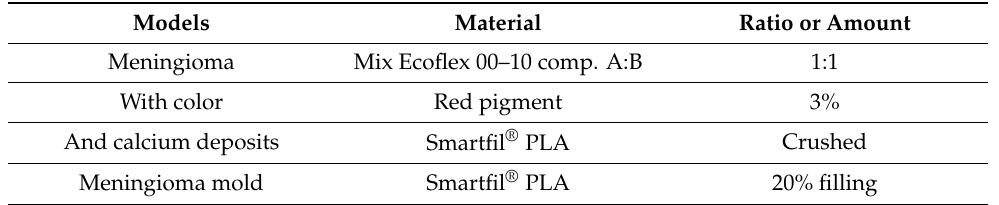
Table 3. Material for the tumors. Models Material Ratio or Amount Meningioma Mix Ecoflex 00–10 comp. A:B 1:1 With color Red pigment 3% And calcium deposits Smartfil ® PLA Crushed Meningioma mold Smartfil ® PLA 20%